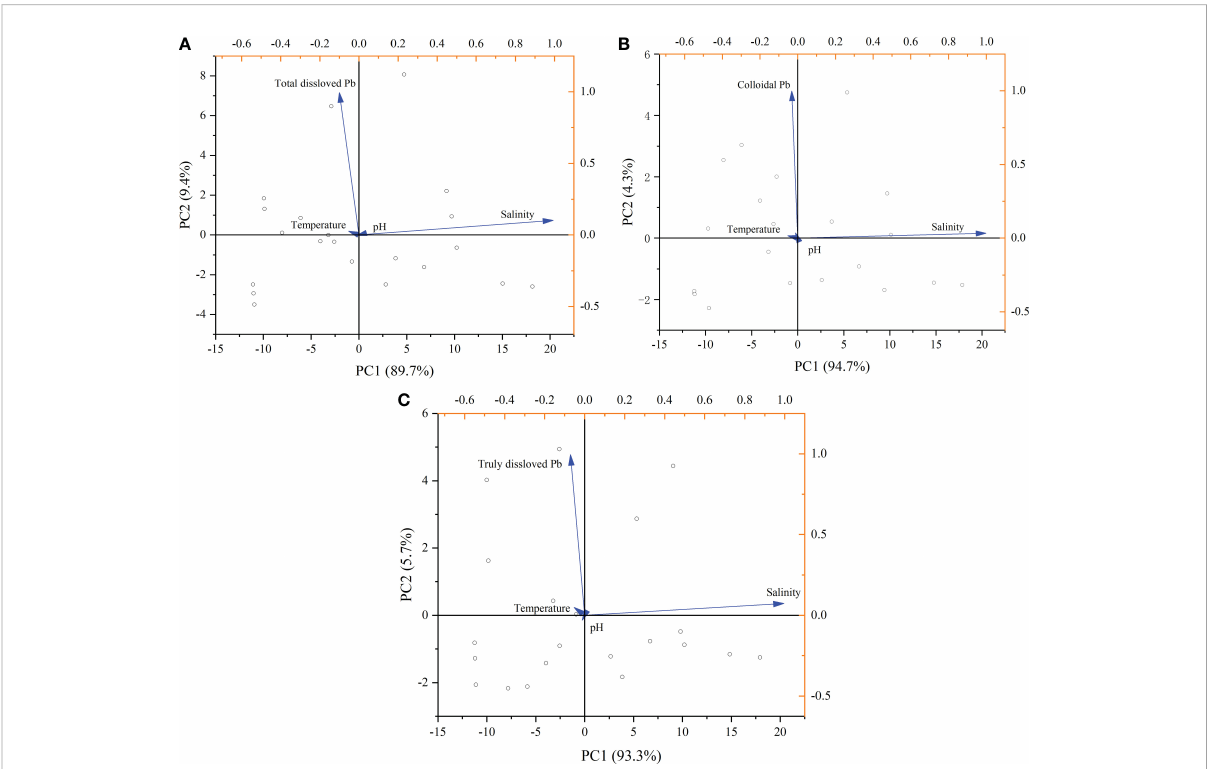
FIGURE 8 The principal component analysis of temperature, pH, and salinity with lead (Pb) at different dissolved states. (A) For total dissolved Pb; (B) for colloidal Pb; and (C) for truly dissolved